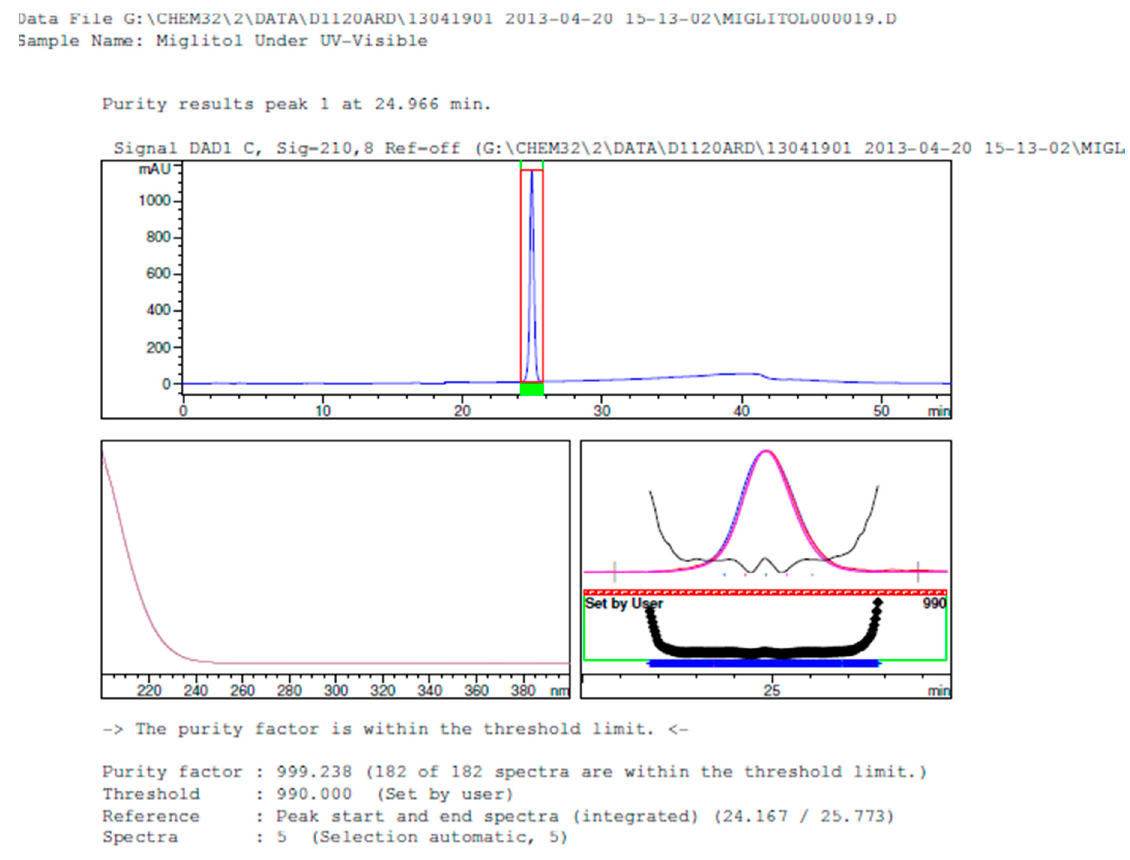
Figure 12. Peak purity in UV-visible degradation by diode array detector. Table 5. Summary of forced degradation